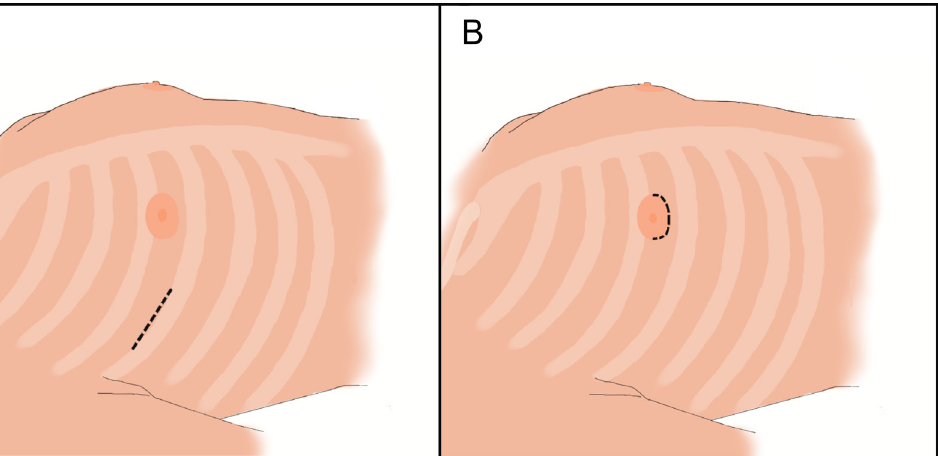
Fig. 1 - (A) Right minithoracotomy and (B) periareolar access incisions for minimally invasive mitral valve